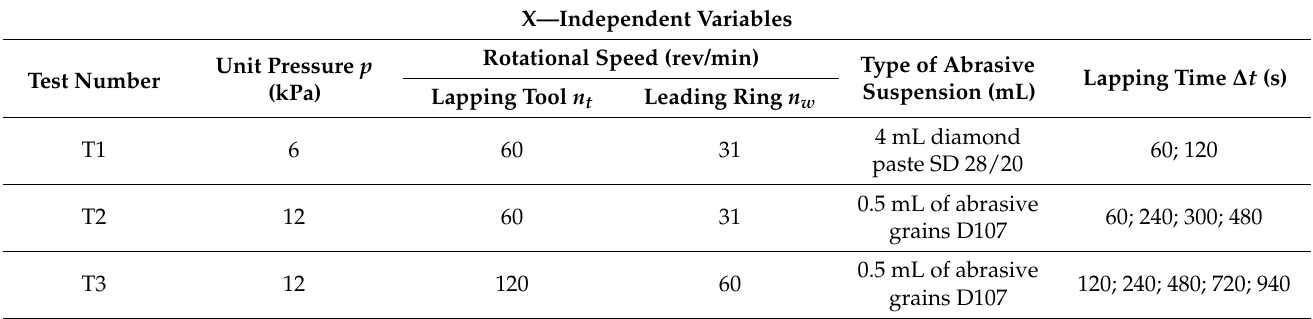
Table 2. A set of machining parameters for pilot tests of single-sided lapping of technical ceramics Al 2 O 3. X—Independent